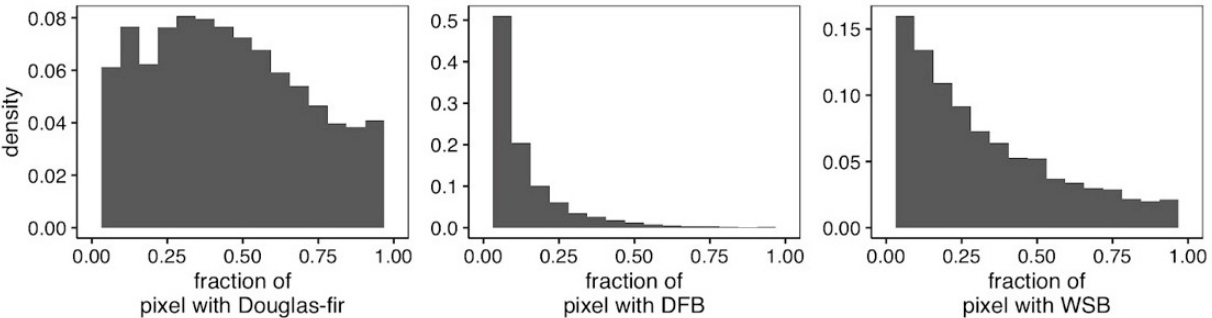
Figure 3. Histograms illustrating the density of observations by the fraction of 960 × 960 m pixels with Douglas-fir, Douglas-fir beetle, or western spruce budworm present, given each was present in the pixel. For DFB and WSB, distributions represent all years combined. Note that y-axes are on different scales to allow for easier interpretation of each panel.